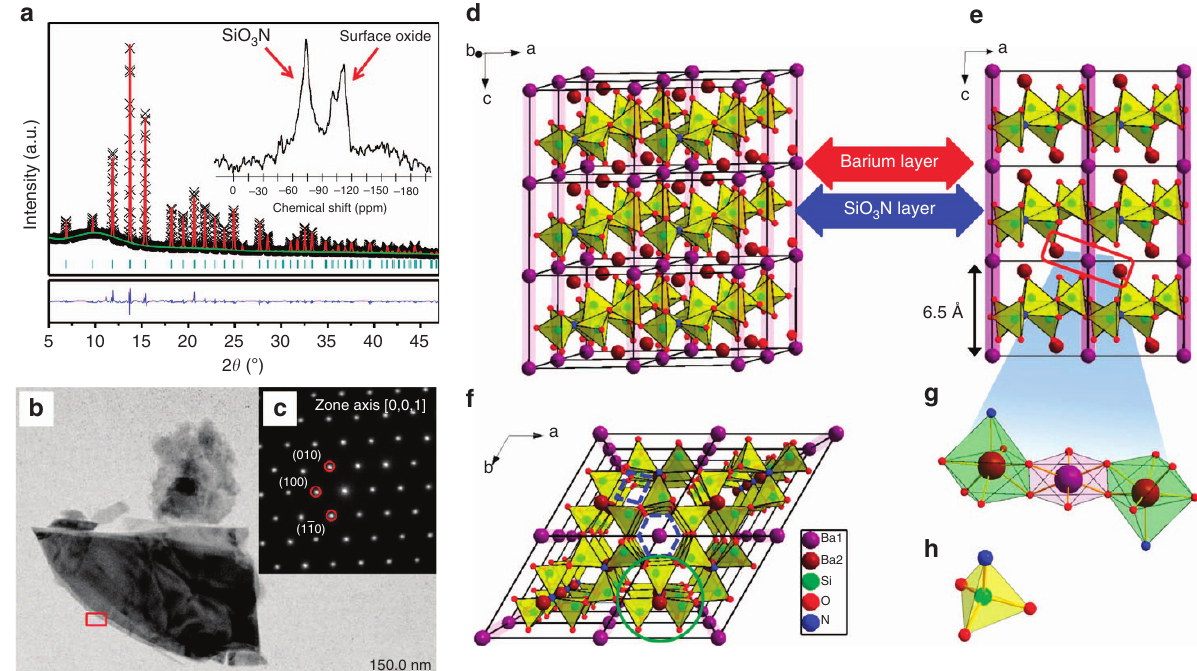
Figure 1 Structure determination and description. ( a ) X-ray Rietveld re fi nements of the Ba 2.89 Si 6 O 12 N 2 :Tb 0.11 material. The observed (crosses), calculated (solid line) and difference pro fi les (bottom) are shown together with the Bragg markers. 29 Si solid-state NMR spectrum of the BSON:Tb compound (inset). ( b ) HRTEM image of the BSON:Tb phosphor. ( c ) SAED pattern along the [001] zone axis. ( d – f ) Crystal structure of the BSON material along various directions. ( g ) Coordination model of two Ba sites that form a slightly distorted octahedron. ( h ) Si atoms are hidden in the tetrahedral inside. (Ba1: purple, Ba2: dark red, Si: green, O: red, and N: